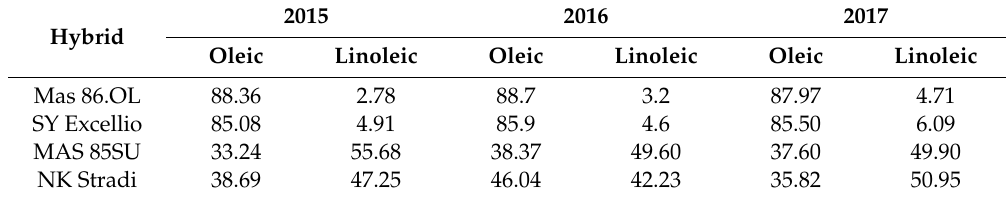
Table 5. Fatty acid content (only oleic and linoleic acid) in hybrids cultivated in di ff erent years. Hybrid